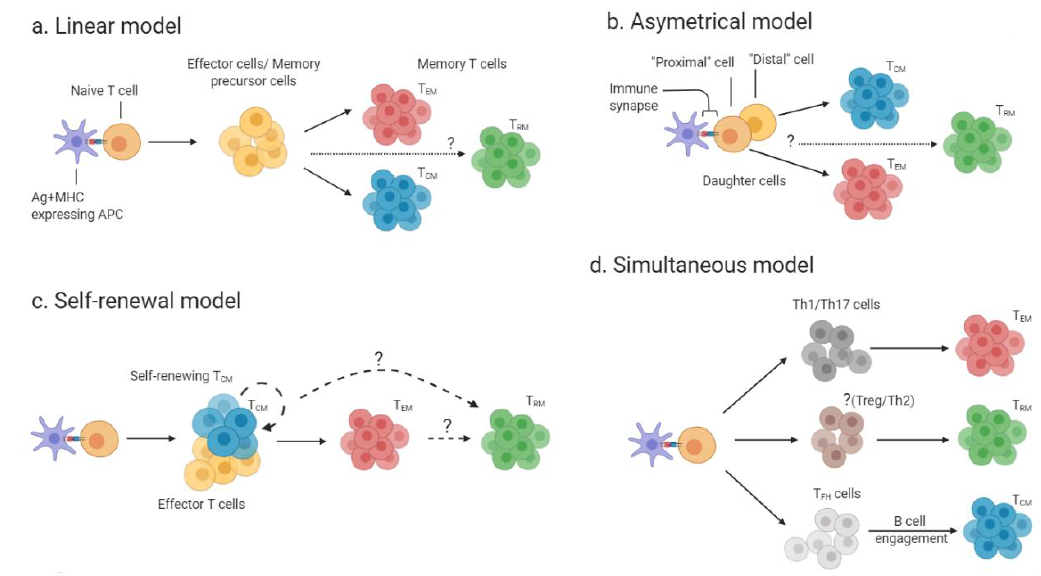
Figure 1. Developmental models of memory T cells: (a) In the linear model, effector T cells or memory precursor cells (yellow) are generated following activation of naïve T cell by antigen-presenting cells (APCs) presenting peptide on major histocompatibility complex (MHC) molecules. The intermediate effectors or memory precursors give rise to mature effector memory T cells (T EM) (red) and central memory T cells (T CM) (blue). It remains to be answered if the intermediate effectors/precursors also give rise to tissue-resident memory T cells (T RM ) ( b ) In the asymmetrical model, the proximal daughter cells to the immune-synapse (naïve T cell- T cell receptor (TCR) + peptide and MHC-APC) develop into T EM , while the distal daughter cells develop into T CM . It is currently unknown which cells give rise to T RM (green). ( c ) In the self-renewal model self-renewing effector T cells or T CM are generated from naïve T cells. These self-renewing cells can then give rise to T EM cells. It is unresolved if T RM are generated from self-renewing T CM /effector cells or from T EM . ( d ) In the simultaneous model naïve T cells first differentiate into different T cell subsets. T cell subsets give rise to different memory subsets as follows: Th1 and Th17 cells (dark gray) generate T EM , while T FH cells (light gray) generate T CM . The T helper cell subset(s) that generate T RM has not yet been identified.